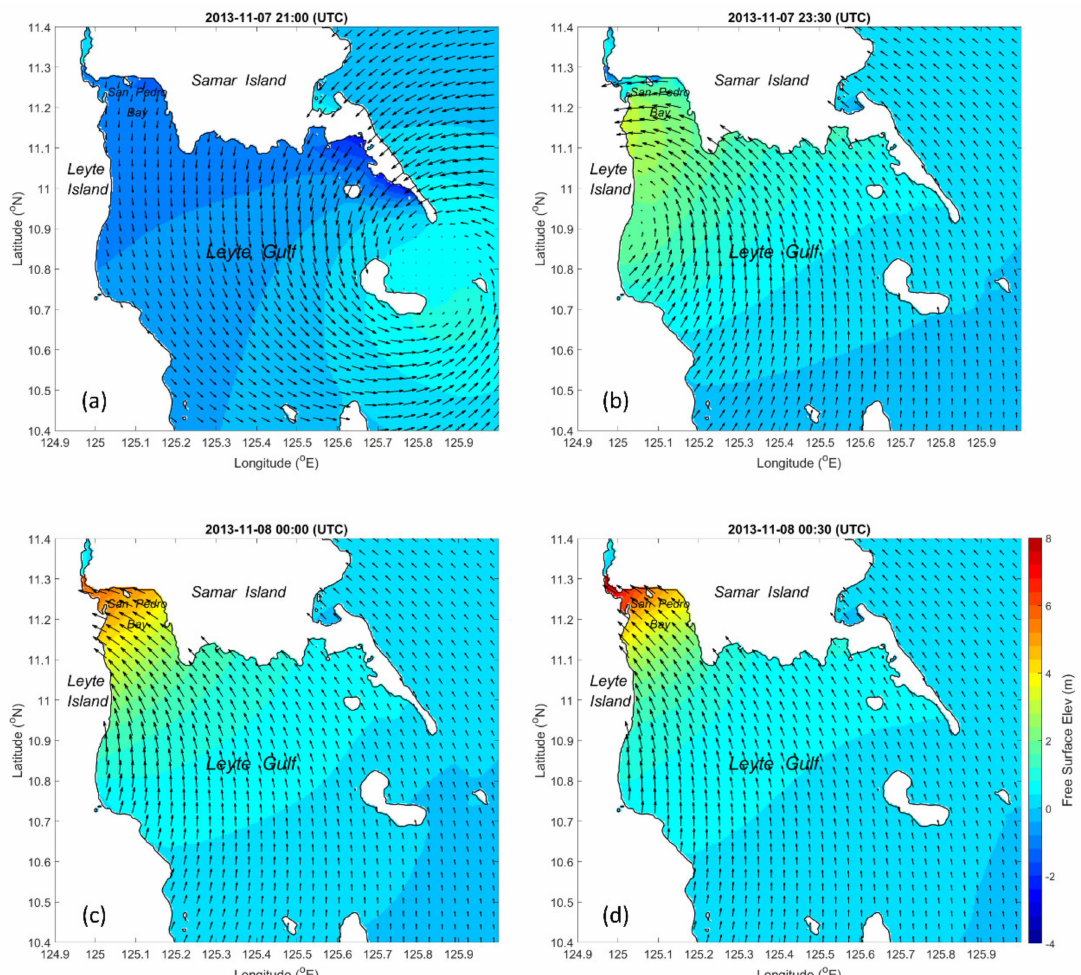
Figure 10. Computed storm surges of Domain D01: ( a ) at 21:00 UTC on 7 November 2013; ( b ) at 23:30 UTC on 7 November 2013; ( c ) at 00:00 UTC on 8 November 2013; ( d ) at 00:30 UTC on 8 November 2013. The color shading indicates the free surface elevations in m, and the black arrows show the 10-m wind